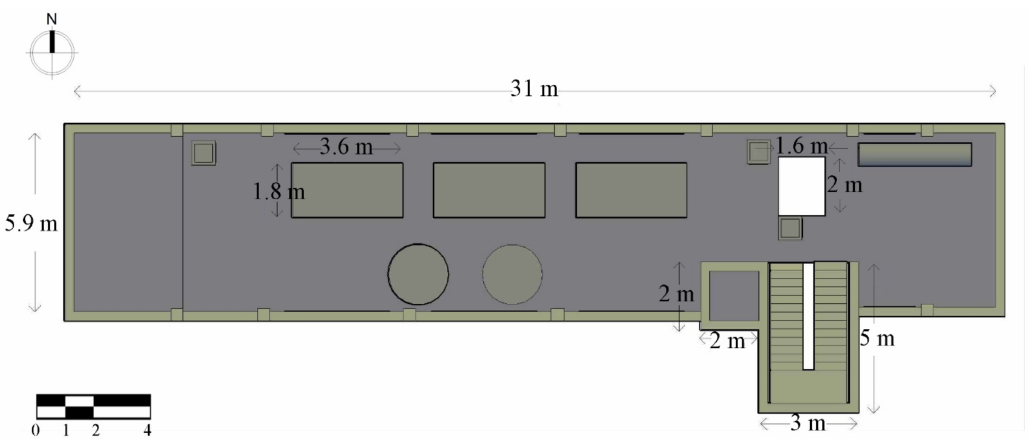
Figure 2. Main dimensions of the floor monitored during the heat